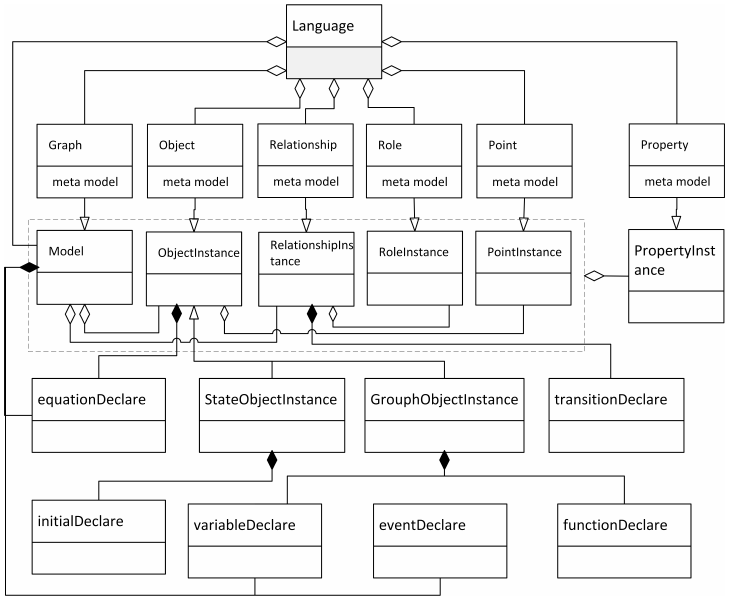
Figure 6. Data structure tree of the extended KARMA language for hybrid automata simulation. Table 4. Syntax of KARMA language for hybrid automata